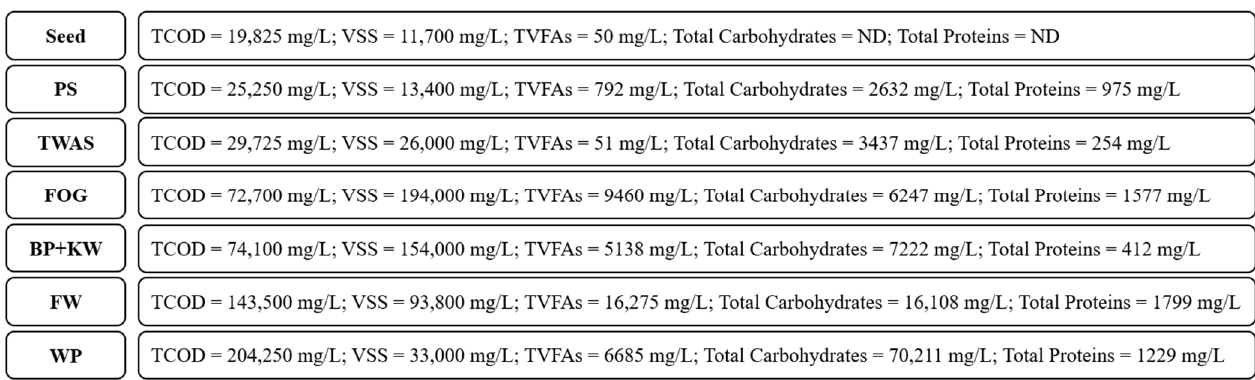
Figure 1. Summary of the characteristics of substrates and inoculum.